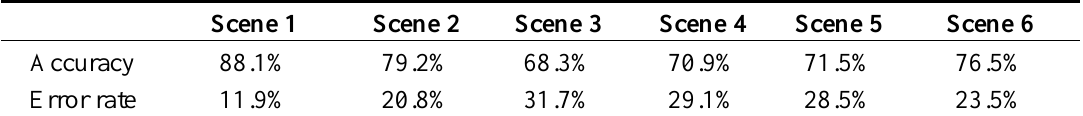
Table 5. Accuracies and error rates for each scene obtained with the proposed